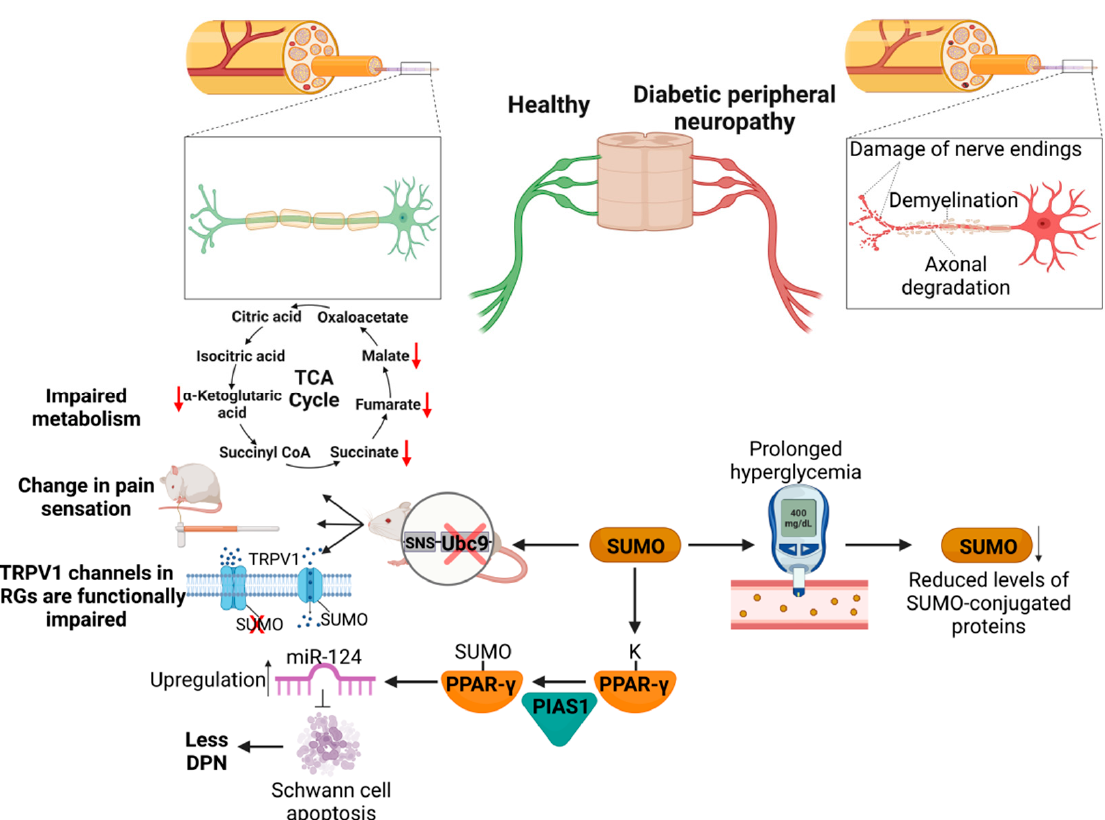
Figure 5. SUMOylation in diabetic peripheral neuropathy: Prolonged hyperglycemia leads to reduced levels of SUMO-conjugated proteins in neuron and Schwann cells. The tissue-specific knockout of SUMOylation in peripheral sensory neurons of DRGs leads to a functional impairment of TRPV1 channels, altered the function of metabolic enzymes and increased the onset of DPN. The SUMOylation of PPAR- γ results in higher miR-124 levels, which inhibit Schwann cell apoptosis. Figure was created with Biorender.com.